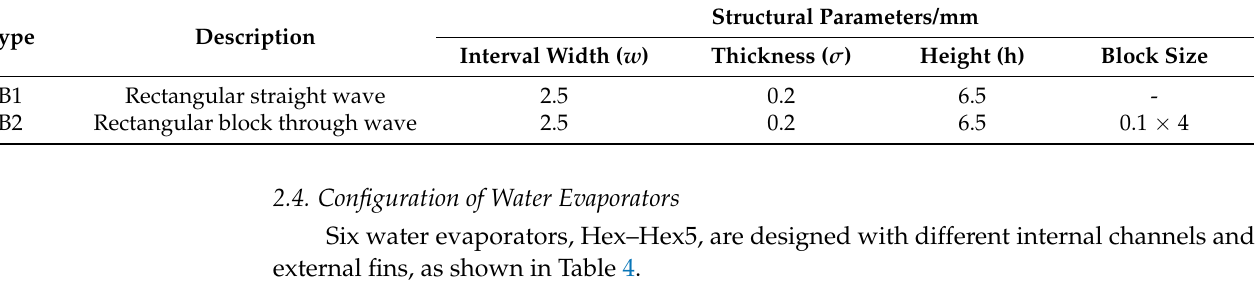
Table 4. Configuration of water